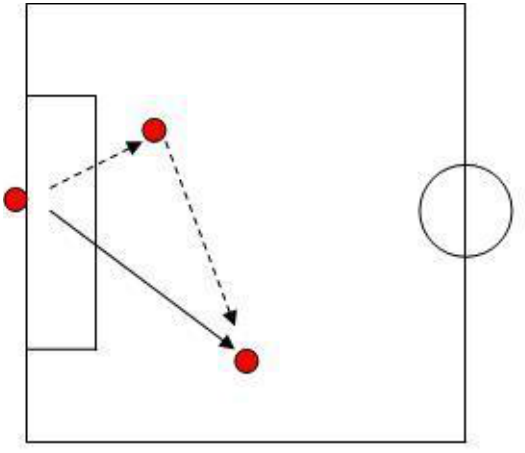
Figura 4. Variação do exercício de reposição de